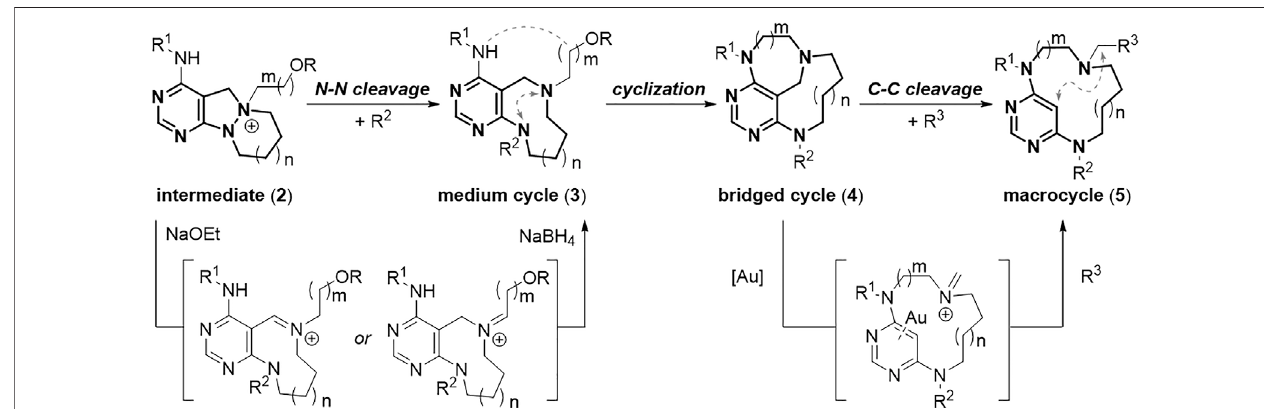
FIGURE 3 | Overall synthetic route for pyrimidine-embedded medium/macro- and bridged cycles.